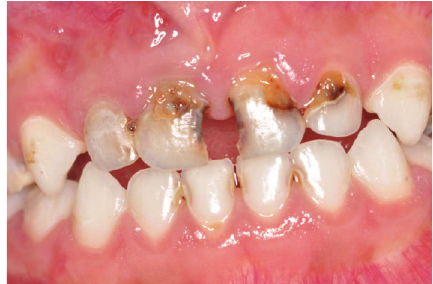
Figure 1: Clinical aspect of early childhood caries.